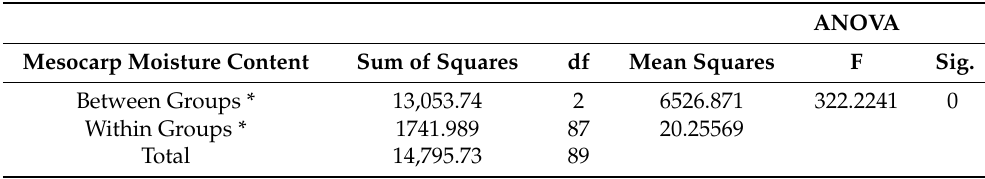
Figure 1. Effect maturity stages on ( a ) moisture and ( b ) oil content of mesocarp oil palm fruitlets. Table 1. ANOVA results for mesocarp moisture content data.